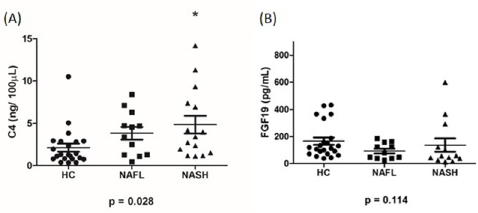
Fig 3. Serum C4 and FGF19 levels in HC, NAFL and NASH groups. (A) Serum C4 levels in HC, NAFL and NASH ( n = 48) * p < 0.05 compared to HC. (B) Serum fibroblast growth factor 19 (FGF19) levels in HC, NAFL and NASH ( n =